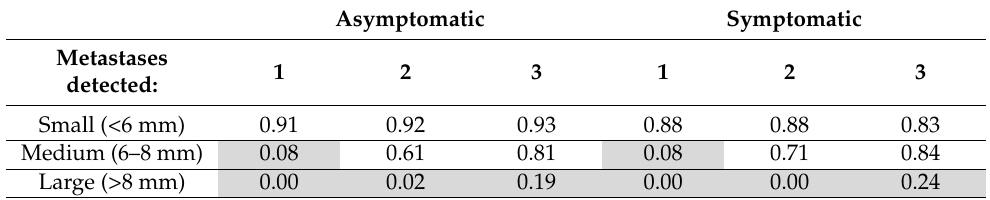
Proportions of oligo+ per risk sub-group. Grey fields represent the low-risk group.